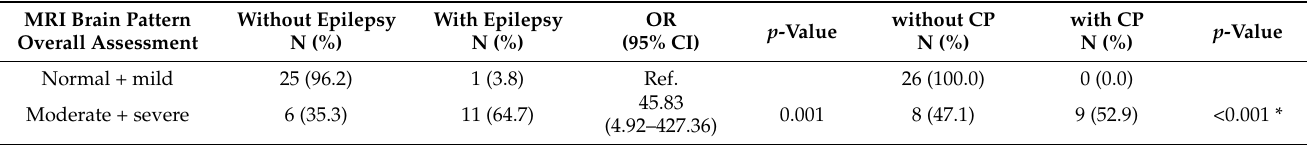
Table 3. The association of category of MRI brain pattern with epilepsy and cerebral palsy